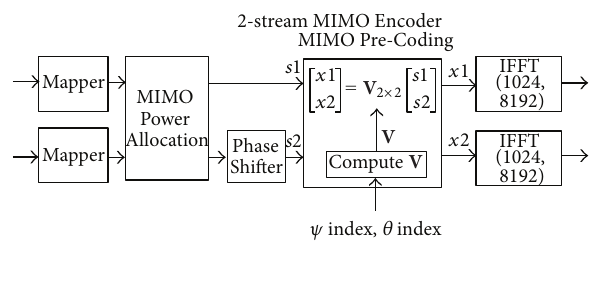
Figure 6: Precoding at the